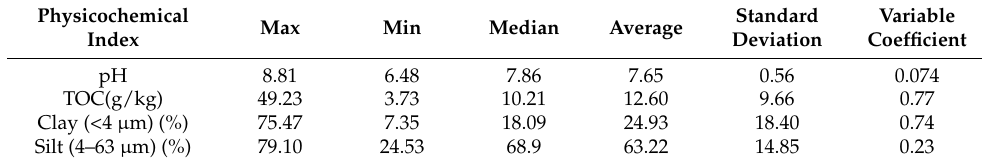
Table 1. Physicochemical properties data for surface sediment in the Taipu River.